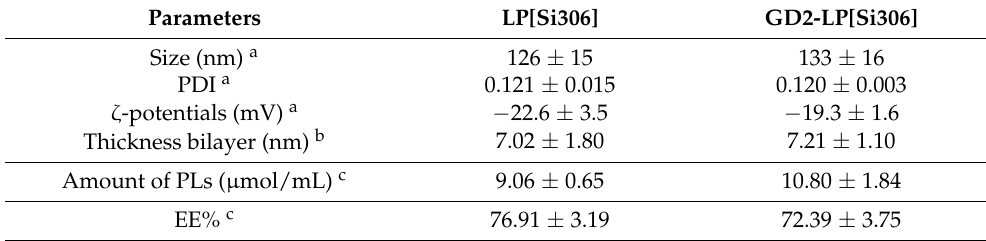
Table 1. Properties of LP[Si306] and